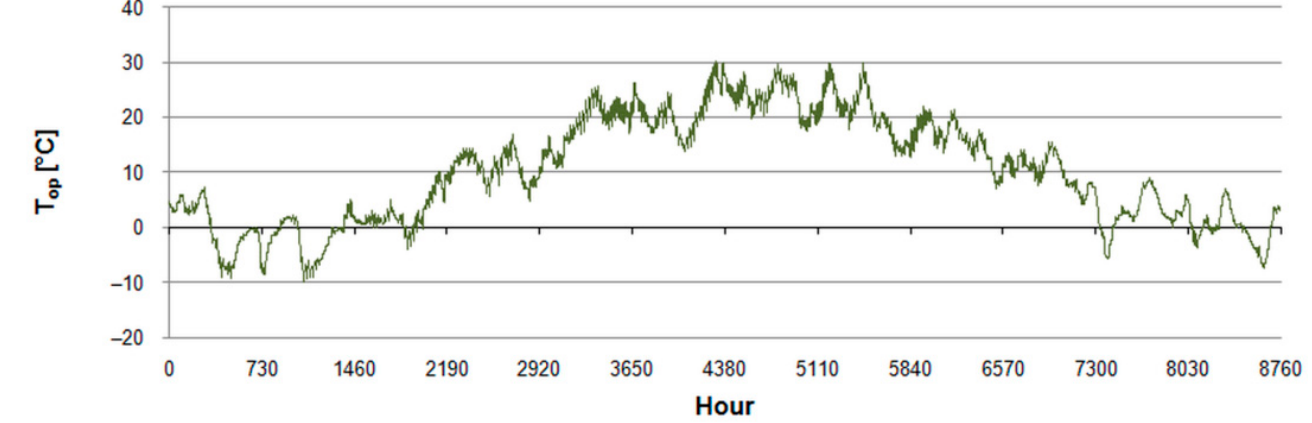
Figure 7. Hourly operative temperature in free-running conditions in the base case.